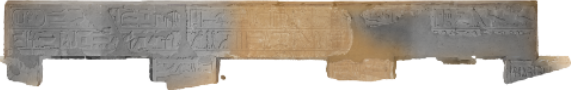
Figure 9 . Orthophotography of architrave D2-D2’.